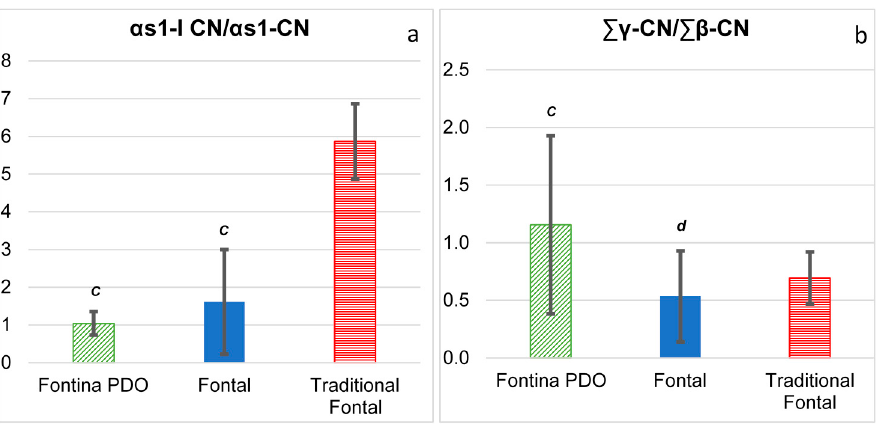
Figure 2. Primary proteolysis extent in commercial samples of Fontina PDO ( n = 11), Fontal ( n = 9) and traditional Fontal ( n = 2) cheeses. ( a ) Degradation of α s1-casein; ( b ) degradation of β -casein. The results are presented as mean ± standard deviation. Statistical analysis was carried out between Fontina PDO and Fontal cheeses only. Mean values with different letters are significantly different ( p < 0.05; t -test).